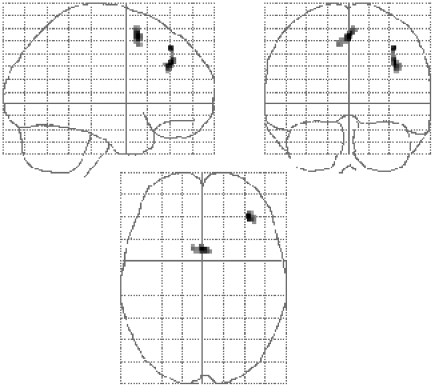
Differences in neural activation between the trained and naïve groups.Shown projected on to a “glass” brain are the activations which are greater in the trained as opposed to the naïve group of subjects for the additive effects contrast SmodAmod>(SmodAØ and SØAmod)>SØAØ. The statistical constraints are as described for Figure 2.